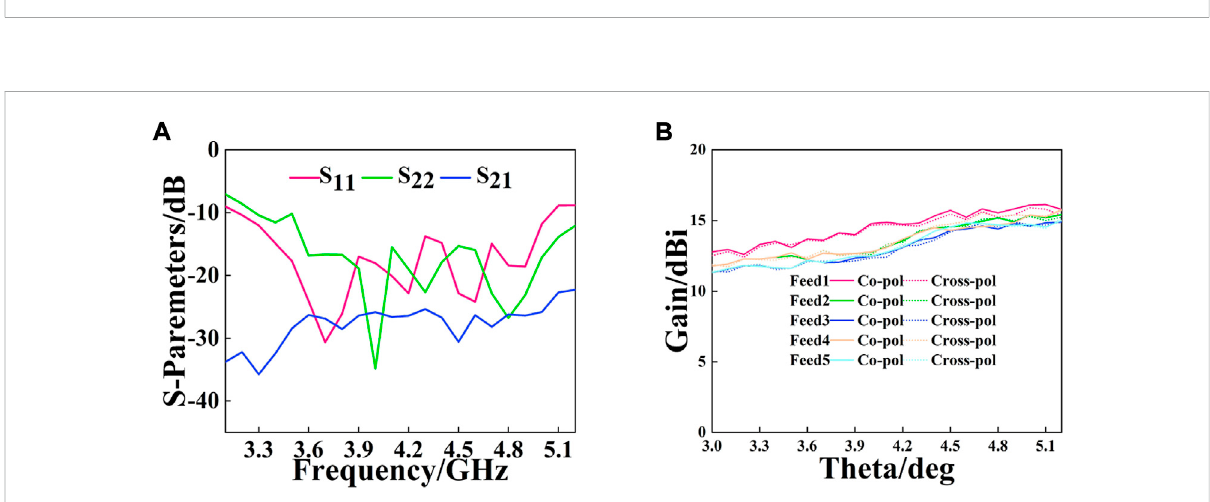
FIGURE 7 The elliptical cylindrical Luneburg lens. (A) The feed antenna. (B) The 3-D printed lens. (C) The overall structure.